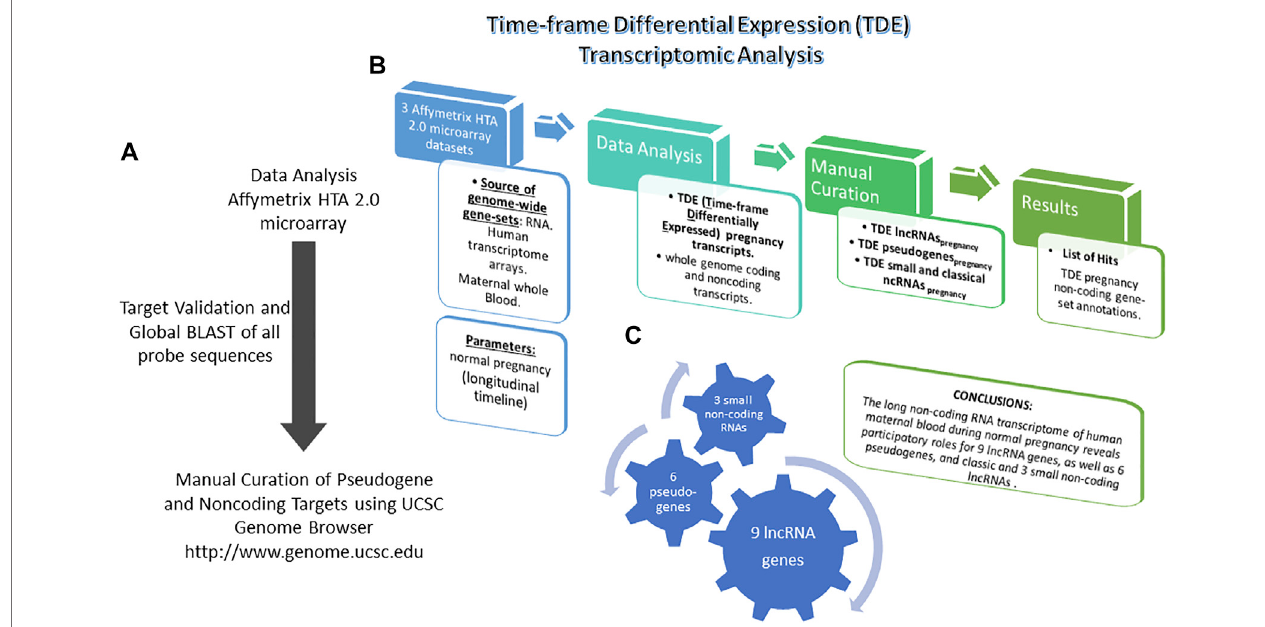
FIGURE 1 | Pregnancy timecourse differential expression analysis, probe curation, fi ltering and manual annotation of non-coding targets. (A) Experimental approach. (B) Experimental phases. (C) Results of study.